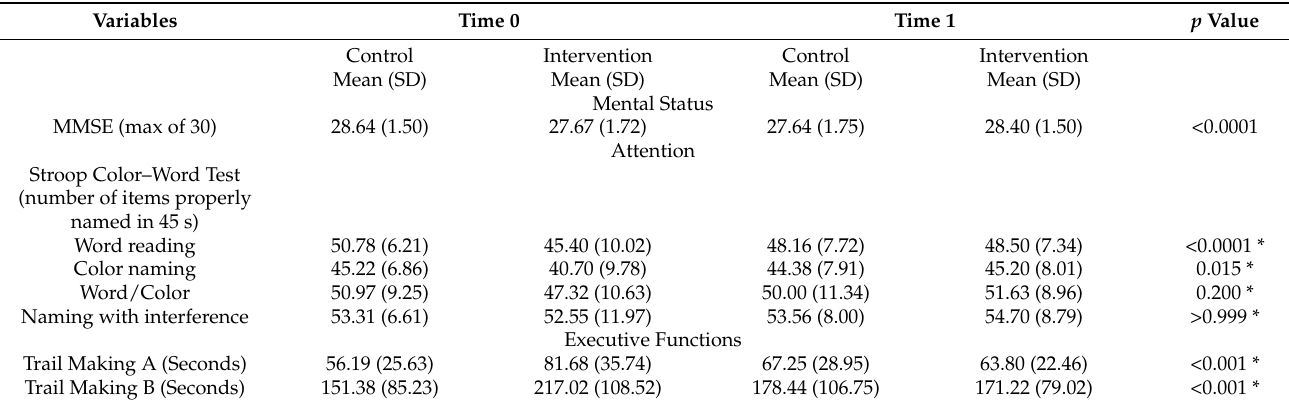
Table 2. Mean, Standard deviation and p value for the Mental State Examination, the Stroop Test and the Trail Making Test over time (pre and post) for the control and intervention groups (CG/IG).